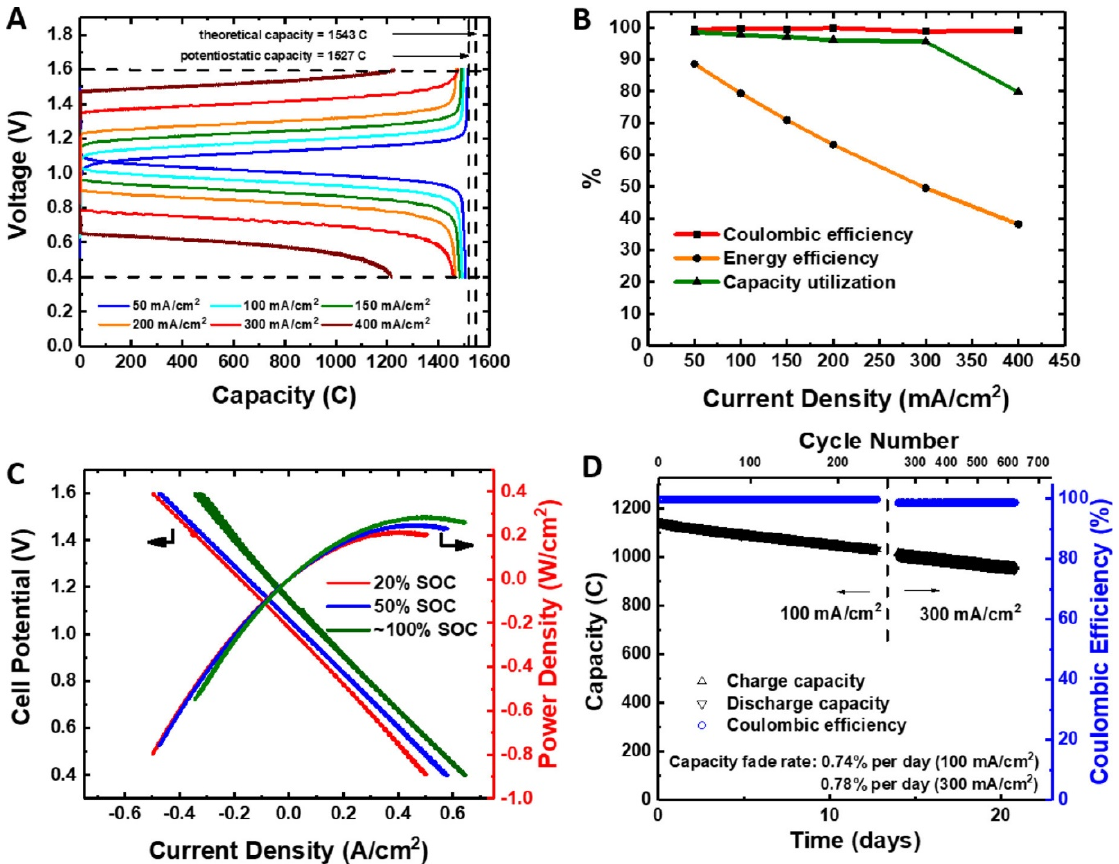
Figure 8. Full cell characterization of 0.5 M bislawsone negolyte in 1 M KOH and 0.3 M potassium ferrocyanide and 0.1 M potassium ferricyanide posilyte in 1 M KOH solution. ( A ) Galvanostatic charge–discharge voltage profiles from 50 to 400 mA/cm 2 . ( B ) Efficiencies and capacity utilization versus current density. ( C ) Cell load curves at 20%, 50%, and 100% SOC. ( D ) Coulombic efficiency and charge and discharge capacities during mid-term galvanostatic cycling with potentiostatic hold. Reprinted with permission from ACS Energy Lett. 2019, 4, 8, 1880–1887. Copyright © 2022, American Chemical